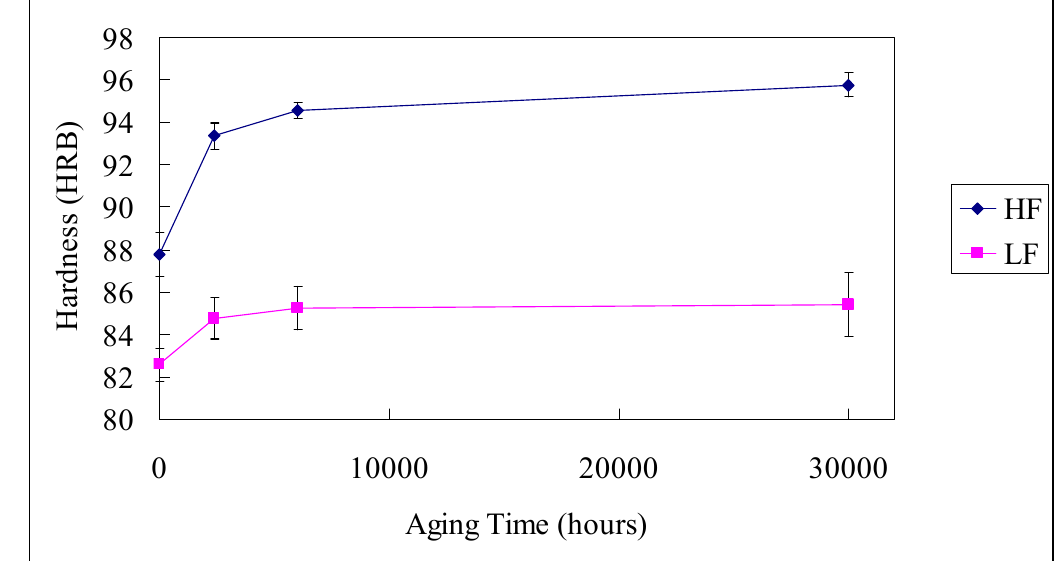
Figure 7. Microstructure and hardness test indentations of specimens age-treated at 385 °C for various periods of time, ( a ) LF 0 h; ( b ) LF 2400 h; ( c ) LF 6000 h; ( d ) LF 30,000 h; ( e ) HF 0 h; ( f ) HF 2400 h; ( g ) HF 6000 h; ( h ) HF 30,000 h.